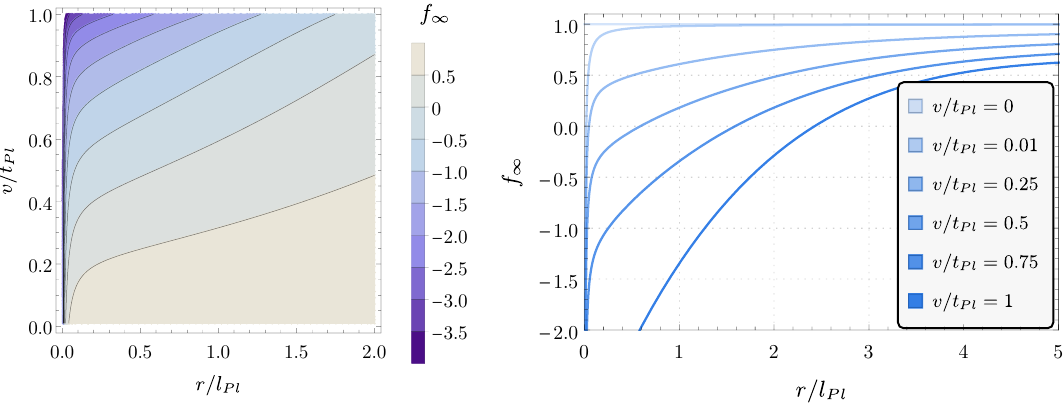
Figure 4 . Time evolution and radial dependence of the lapse function f ∞ ( r, v ) , i.e. the (0 , 0) - component, of the VKP spacetime with effective Newton coupling G the formation of a black hole horizon whose location lies initially at a radius smaller than for the classical VKP model. For sufficiently large masses, the final configuration is approximated well by the Schwarzschild spacetime, at least outside of the Planckian region, i.e., for r (cid:29) l